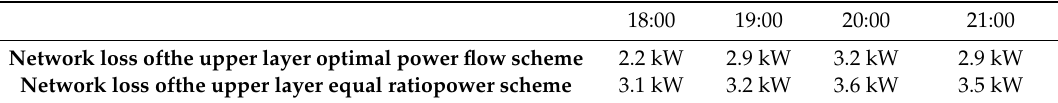
Table 8. Network loss of the two schemes for